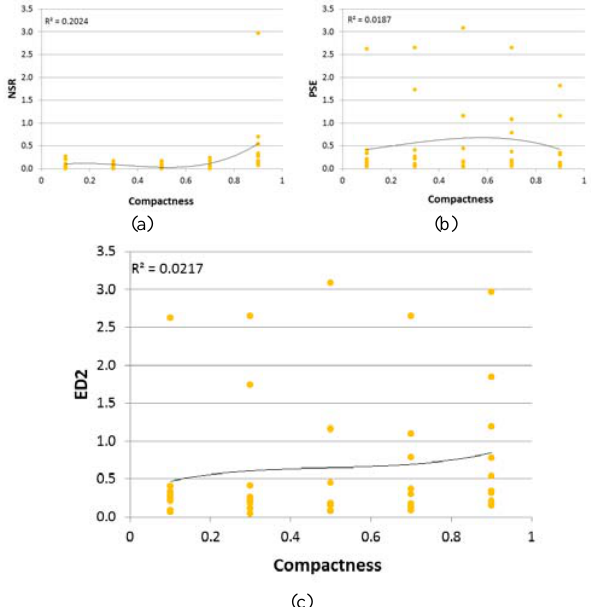
Figure 8. Scattergrams showing the variation with compactness of number-of-segmentation ratio (NSR) (a), potential segmentation error (PSE) (b) and Euclidean distance 2 (ED2) (c), for R1 and R2